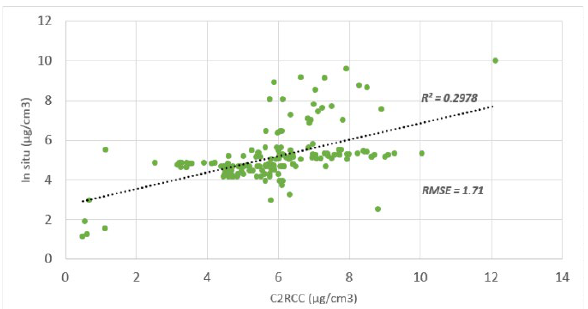
Figure 6. Comparison between in situ and C2RCC-derived